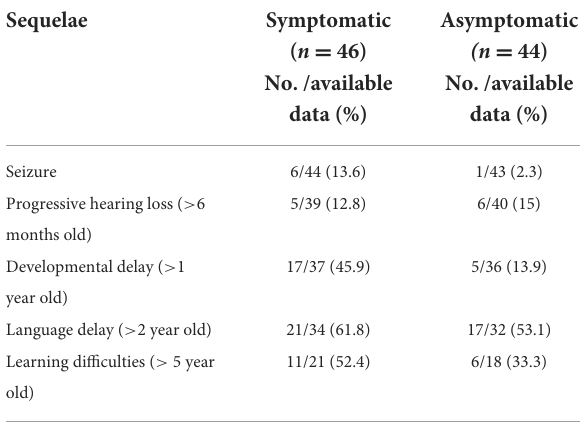
TABLE 4 Sequelae of infants with